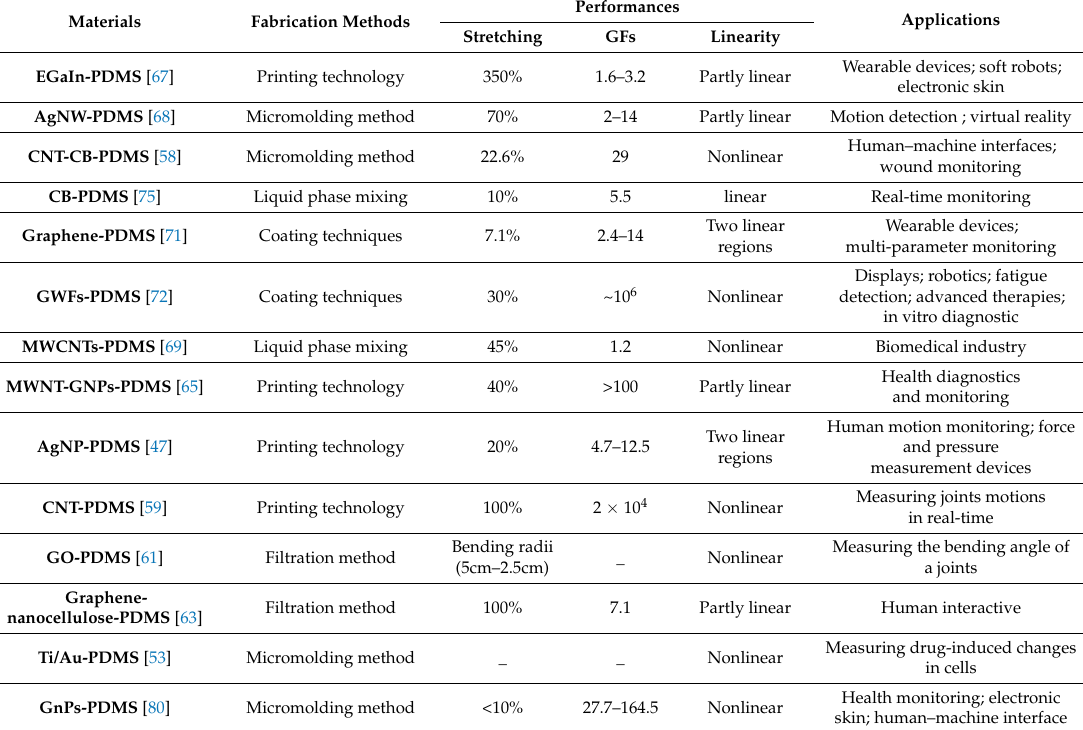
Table 1. Comparison of polydimethylsiloxane (PDMS)-based flexible strain